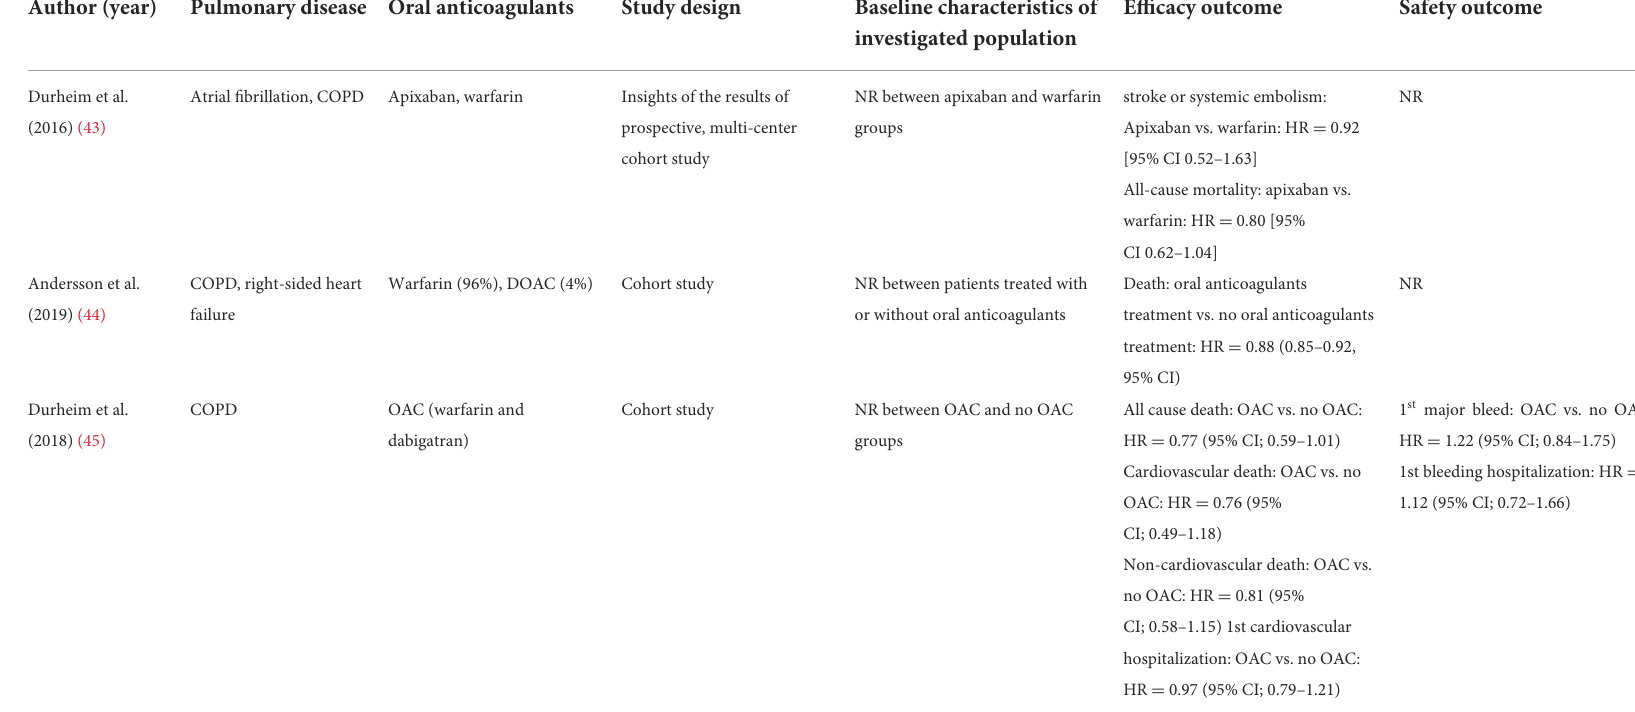
TABLE 4 Summary of included studies of OACs in Patients with